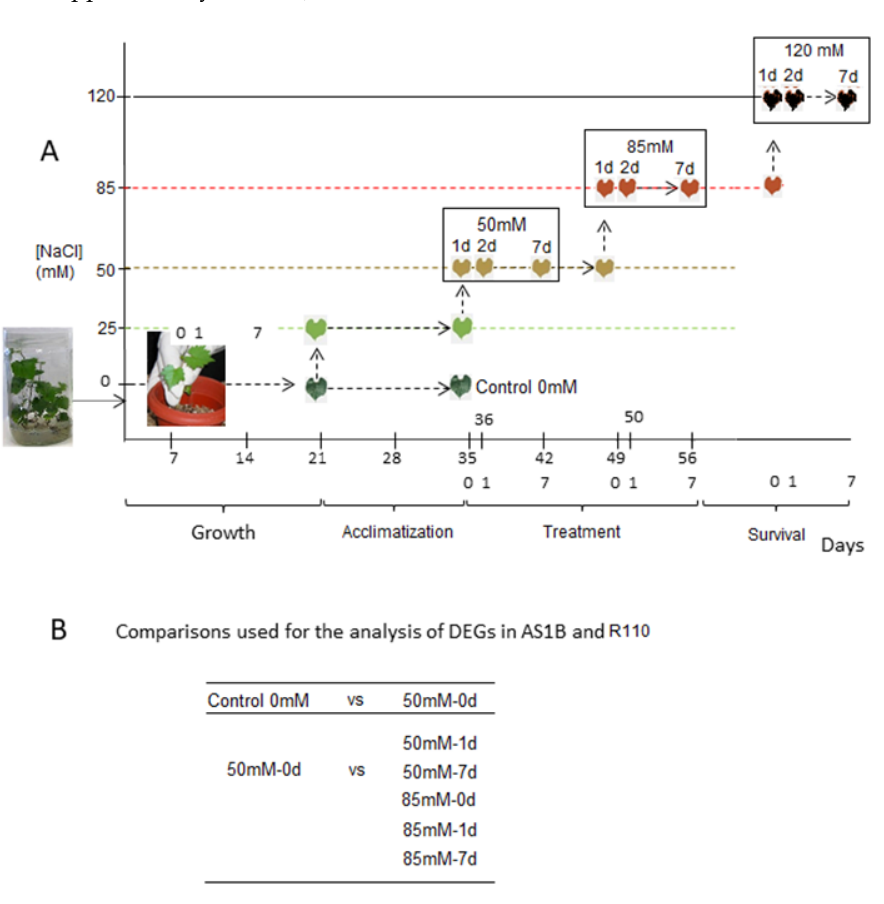
Figure 1. Experimental design and time course of the salt treatments on AS1B and R110 accessions. ( A ) Plants were irrigated with 200 mL of Hoagland’s solution every 2 days for 3 weeks, for the initial growth of the plants. Then, plants were treated with Hoagland solution with the addition of 25 mM NaCl for adaptation phase for 2 weeks, and after that the conditions were created with an increase of 50 mM to 120 mM NaCl. ( B ) Treatment conditions selected for differential expression analysis.